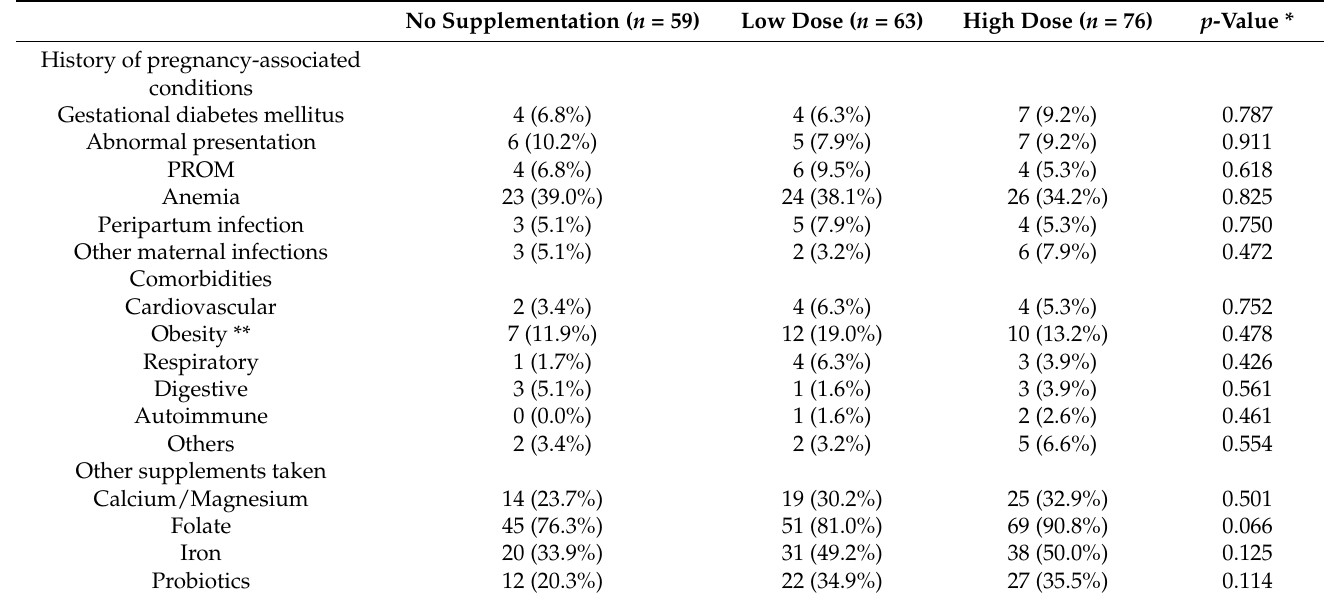
Table 2. Pregnancy characteristics are stratified by the type of vitamin D oral supplementation during pregnancy.